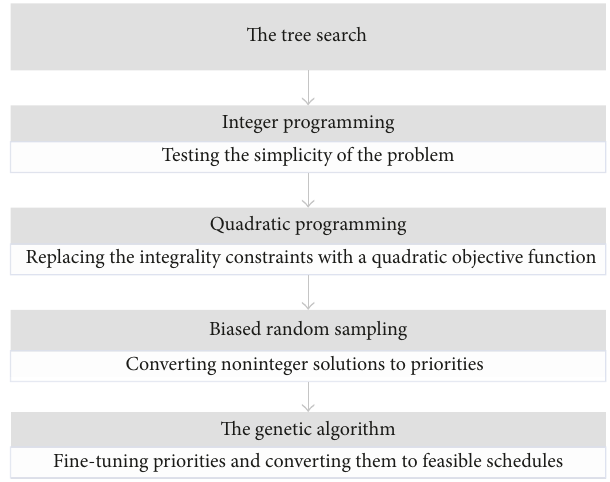
Figure 3: The constituent modules of the